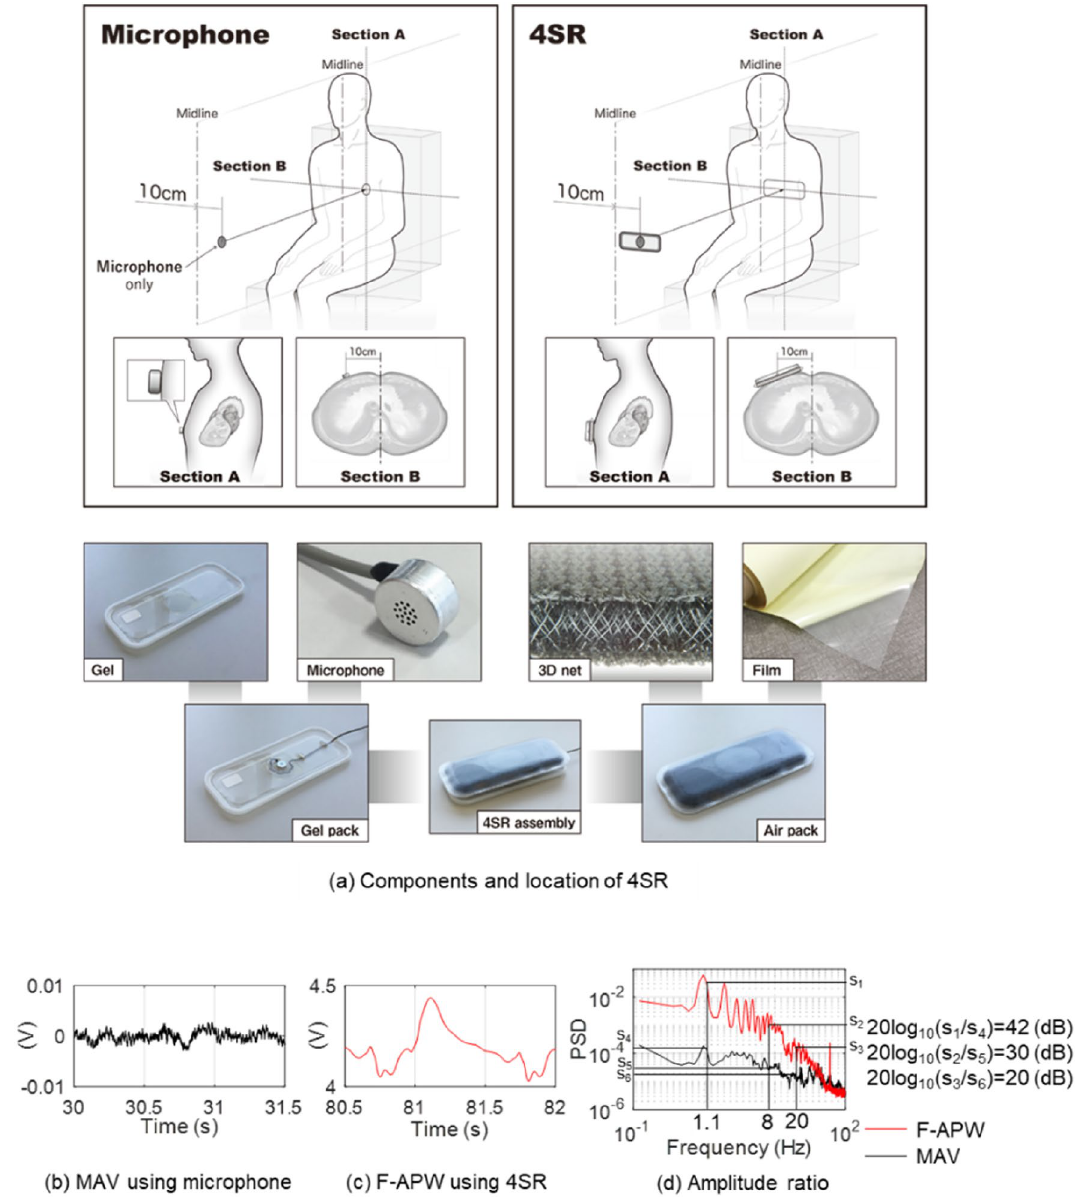
Figure 1. Experimental apparatus and characteristics of 4SR (amplitude ratio). ( a ) The installation position and component configuration of 4SR. 4SR is an assembly comprising of a gel-pack (left photo) and an air-pack (right photo). The gel-pack consists of gel injected into a soft plastic case and a microphone. The air-pack is sealed with an elastomer film and embedded three-dimensional knitted fabrics called 3D net (see the sectional photo) of 10 mm thickness. The air-pack and the gel-pack are fixed together by adhesion of the gel. For comparison, micro acoustic vibration (MAV) was collected using only the microphone. ( b ) MAV obtained using only the microphone. ( c ) F-APW obtained using 4SR. ( d ) The amplitude of apex beats and heart sounds increased almost two 100-fold, and the gain was 20 to 42 dB through mechanical vibration system response and the stochastic resonance